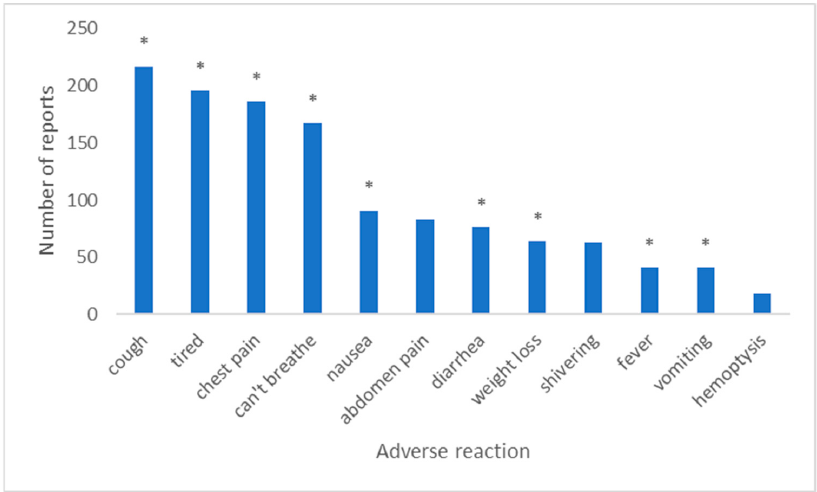
Figure 4. Number of reports for each adverse reaction on YouVape. Stars denote adverse reactions reported by CDC.